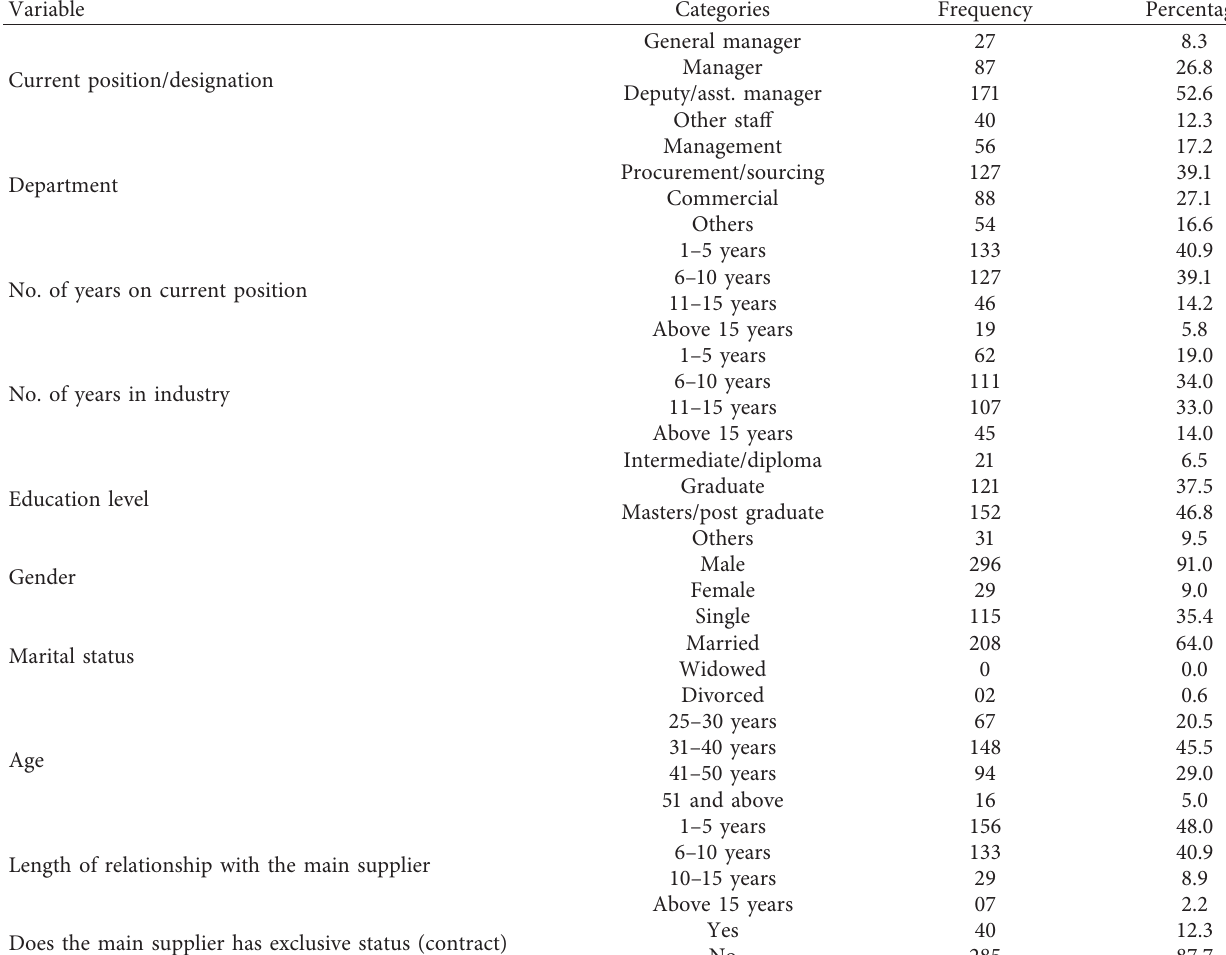
Table 1: Sociodemographic characteristics of the participants ( n �